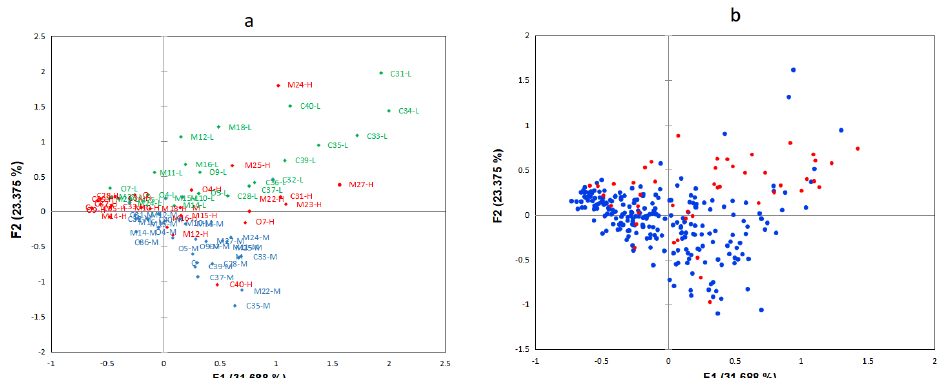
Figure 4. ( a ) Loading plot ( left ) and ( b ) score plot ( right ) of MCA on the food fraud vulnerability of producers and retailers. Notes: In the loading diagram, the letter O before the number represents opportunity, M represents motivation, C represents control measures, and the letters L, M, and H after the number represent low, medium, and high vulnerability, respectively. Table 3. Vulnerability of different groups to fraud factors and Mann-Whitney U